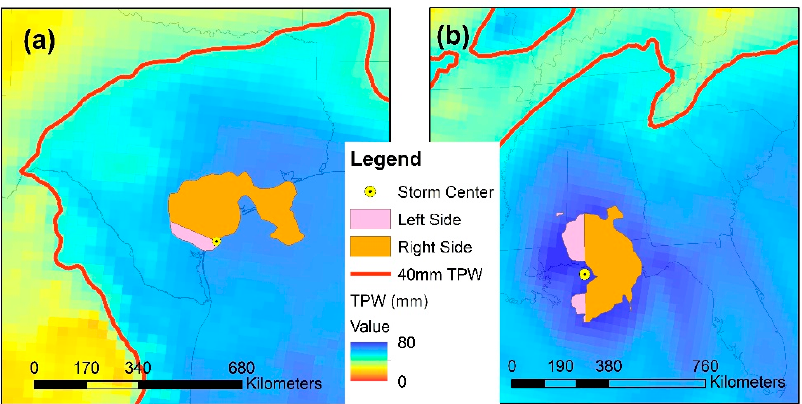
Figure 5. TPW and area occupied by rain rates exceeding 5 mm hr − 1 on the left (pink) and right (orange) sides of each TC. ( a ) 1998 Charley from the western and ( b ) 2004 Ivan from the central group.